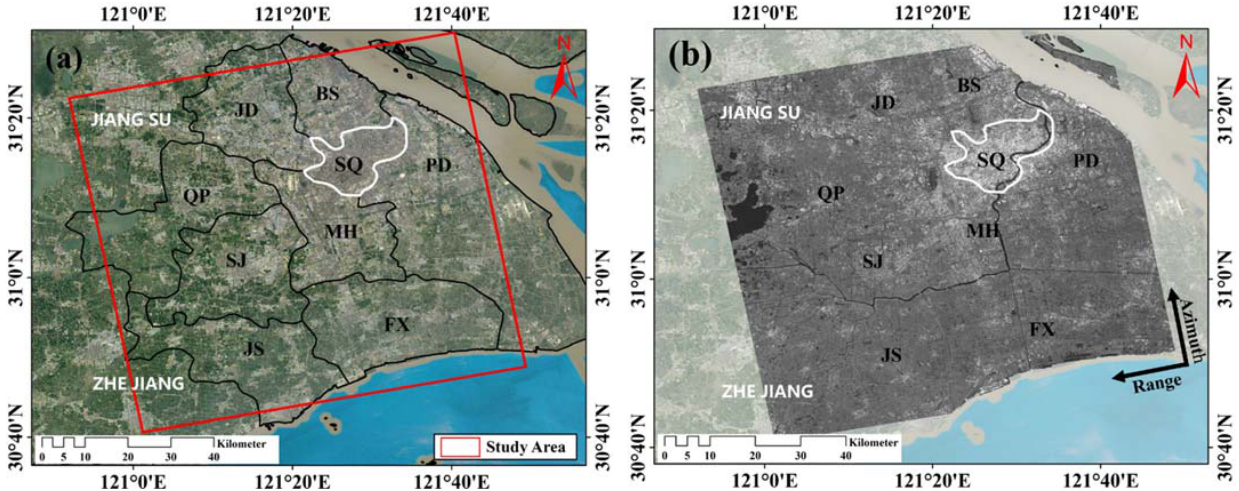
Figure 2. ( a ) The black area is the municipal area of Shanghai, including Baoshan (BS), Jiading (JD), Qingpu (QP), Minhang (MH), Pudong New Area (PD), Songjiang (SJ), Jinshan (JS), and Fengxian (FX); and ( b ) Sentinel-1A image intensity map of the study area. The red rectangle depicts the study area of this paper. The white line corresponds to the urban area of Shanghai (SQ); The black lines represent the division of Shanghai.